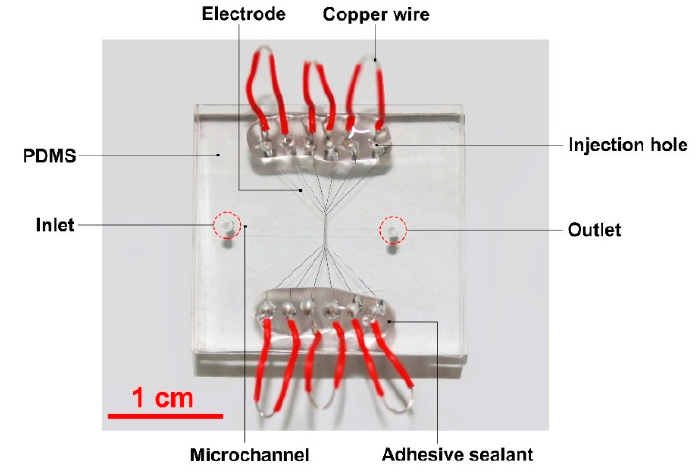
Figure 2. Optical image of a PDMS microfluidic chip for the particle trap though the electric field control induced by the liquid metal electrodes.